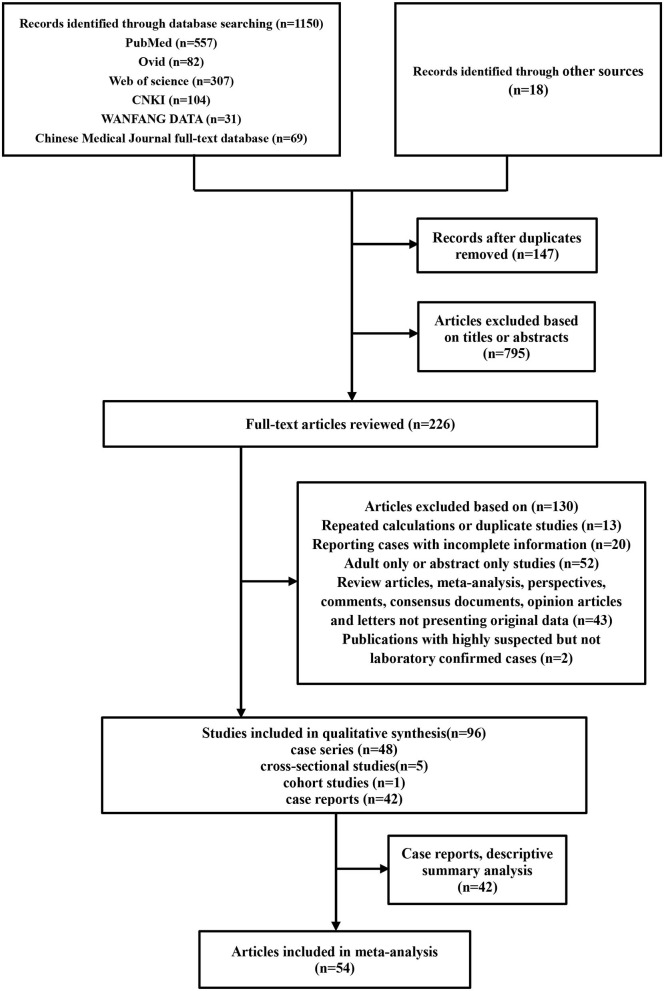
Flowchart depicting the literature search and selection strategy. After applying the inclusion and exclusion criteria, a total of 54 articles were included in the final meta-analysis.